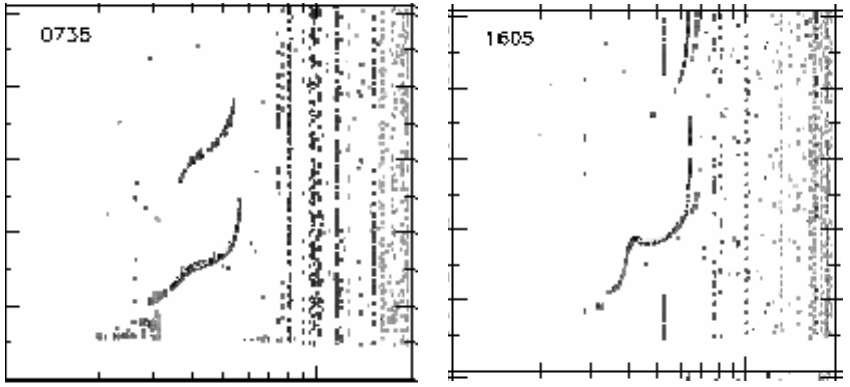
Fig. 2b. Ionograms recorded at 07:35 (left) and 16:05IST (right) on 26 June 2007, showing various E sq conditions. (left) Ionogram sample Figure 2(b) : Ionograms recorded at 0735 (left) and 1605 IST (right) on 26 June 2007, depicting the presence of E sq and (2) (right) ionogram indicating the absence of E sq trace. showing various E conditions. (left) Ionogram sample depicting the presence of E and sq sq (2) (right) ionogram indicating the absence of E trace. the lower E-region heights. The pattern orientation can be Sq seen strongly aligned in the north-south direction even at heights as low as 86 km during the times (10:00 to 15:00 IST) when the EEJ was strong. The axial ratio and the pattern scale do not appear to show any dependence on EEJ on this day, though in general these parameters were smaller at 94 and 98 km than those estimated for 86 and 90